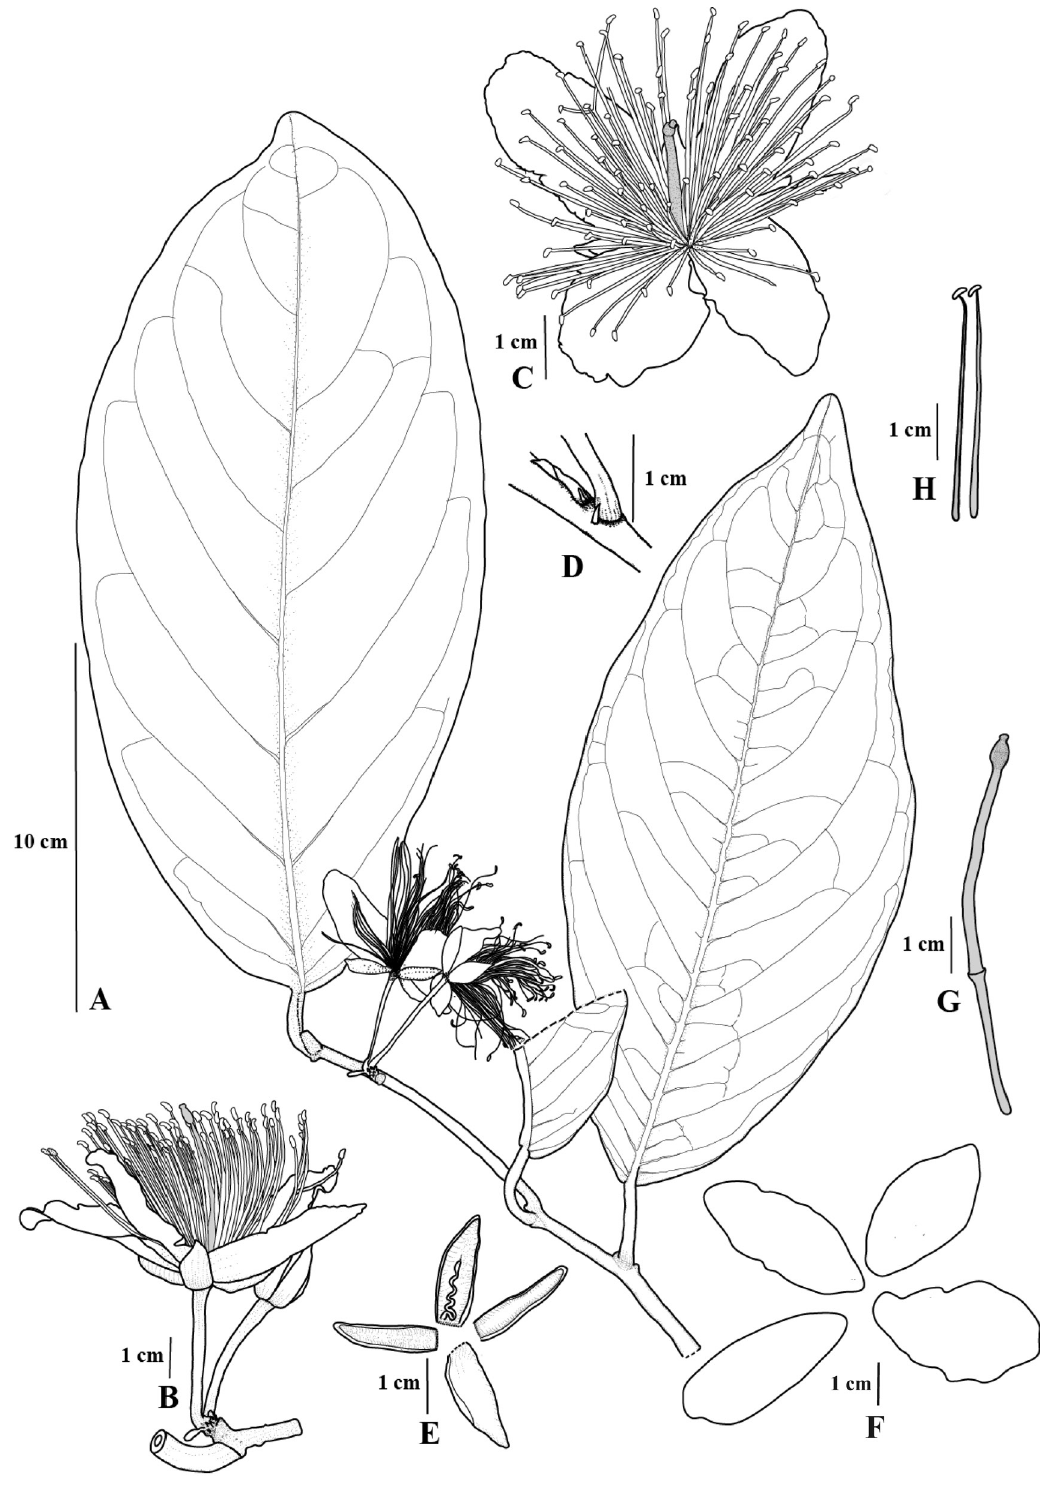
Fig. 1. Capparis macrantha Souvannakhoummane, Fici & Lanorsavanh sp. nov . A . Flowering branch. B . Flower (lateral view). C . Flower (front view). D . Stipular thorn and petiole. E . Sepals. F . Petals. G . Gynophore and ovary. H . Stamens. Drawn from holotype ( Lanorsavanh et al. SL1641 ) by K.